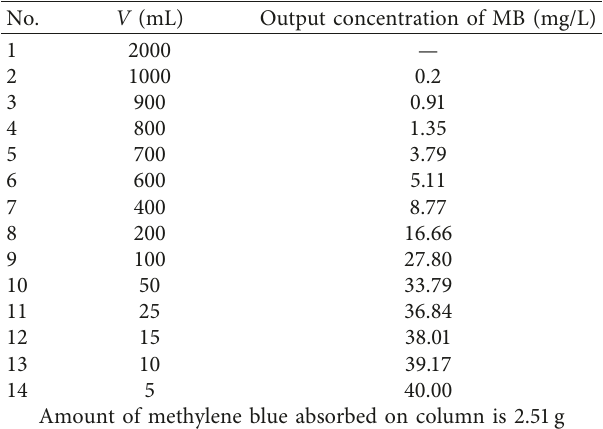
Table 2: Results of the large-scale surveys on adsorption perfor- mance of M2.